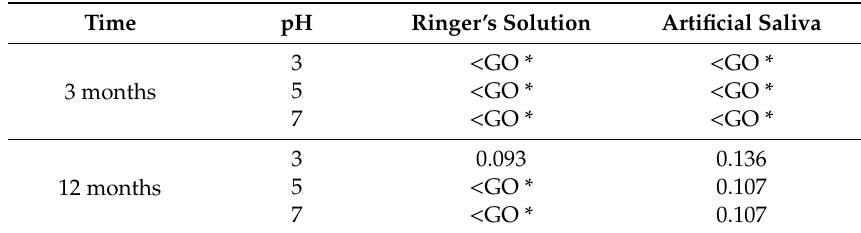
Table 2. Titanium content according to ICP-MS analysis at different pH (mg/kg). pH Ringer’s Solution Time